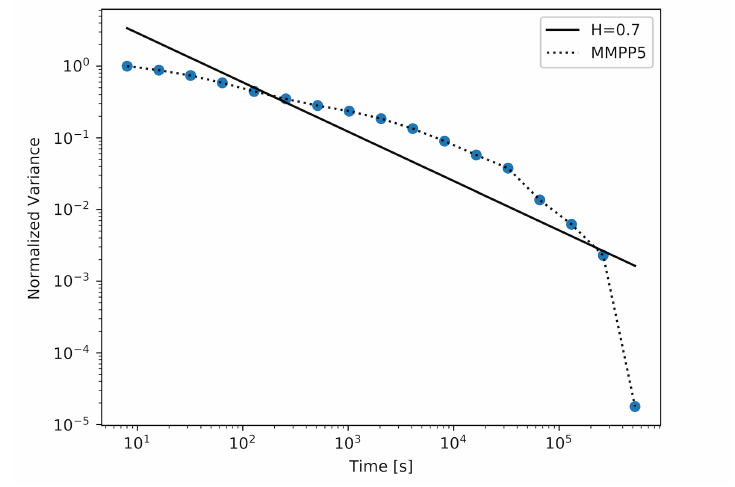
Figure 4. The aggregate variance of the sample in several time scales with the MMPP model, d =